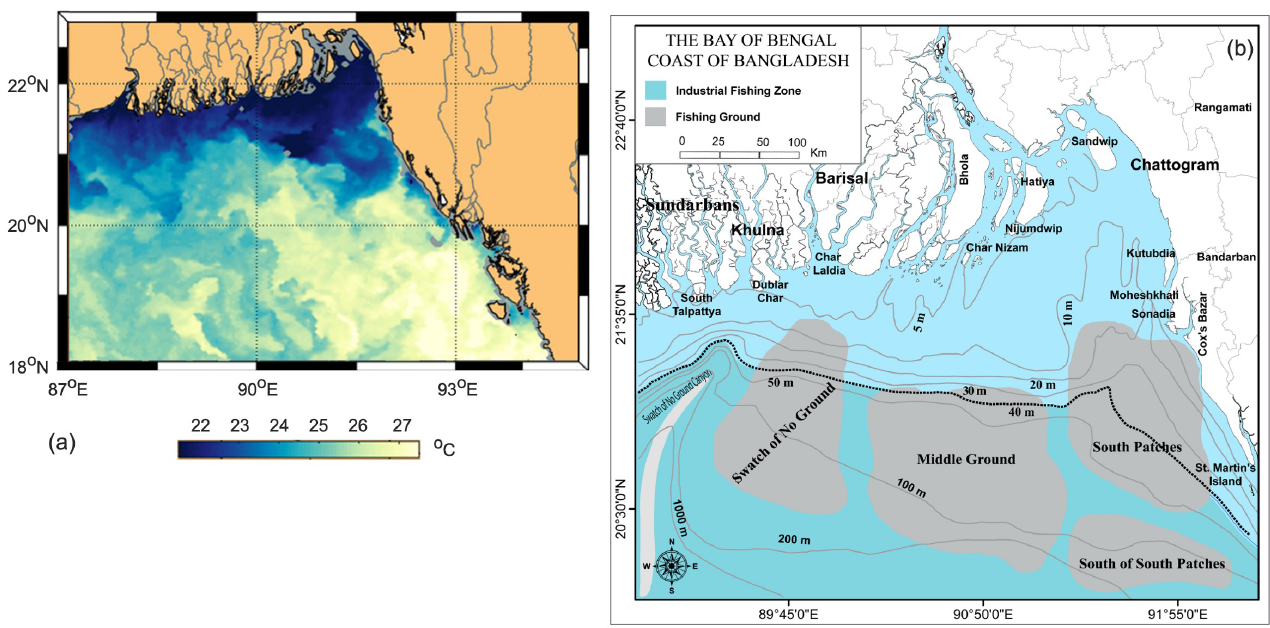
Figure 9. Dynamics of: ( a ) winter sea surface temperature [adapted from NASA], and ( b ) contour of the depth of the Bay of Bengal (adopted from © Alam et al, [ 55 ] ) licensed under CC BY.